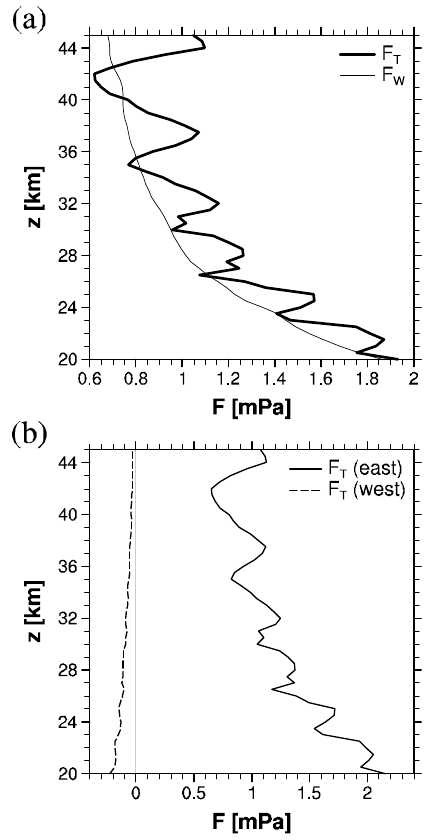
Fig. 1. Momentum-flux profiles (a) estimated from temperature variances (thick) and calculated from wind perturbations (thin) and (b) estimated from temperature variances for eastward (solid) and westward propagating (dashed) waves.